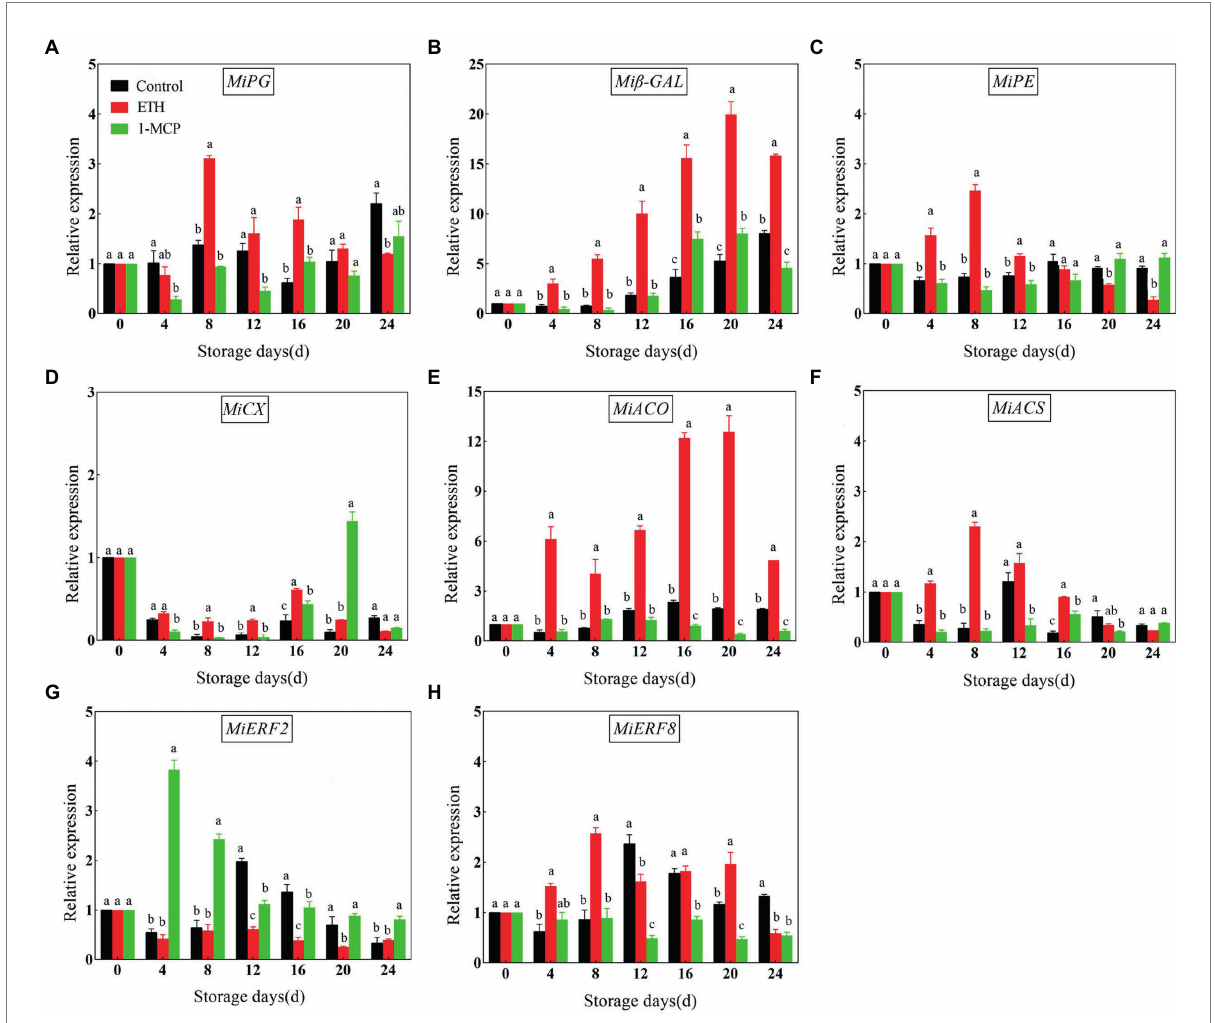
FIGURE 4 Effects of different treatments on expression levels of MiPG (A) , Mi β -GAL (B) , MiPE (C) , MiCX (D) , MiACO1 (E) , MiACS6 (F) , MiERF2 (G) and MiERF8 (H) in mango fruit during storage at 15 ° C. The data are presented as means ± standard deviations. Means with different letters are significantly different at p <